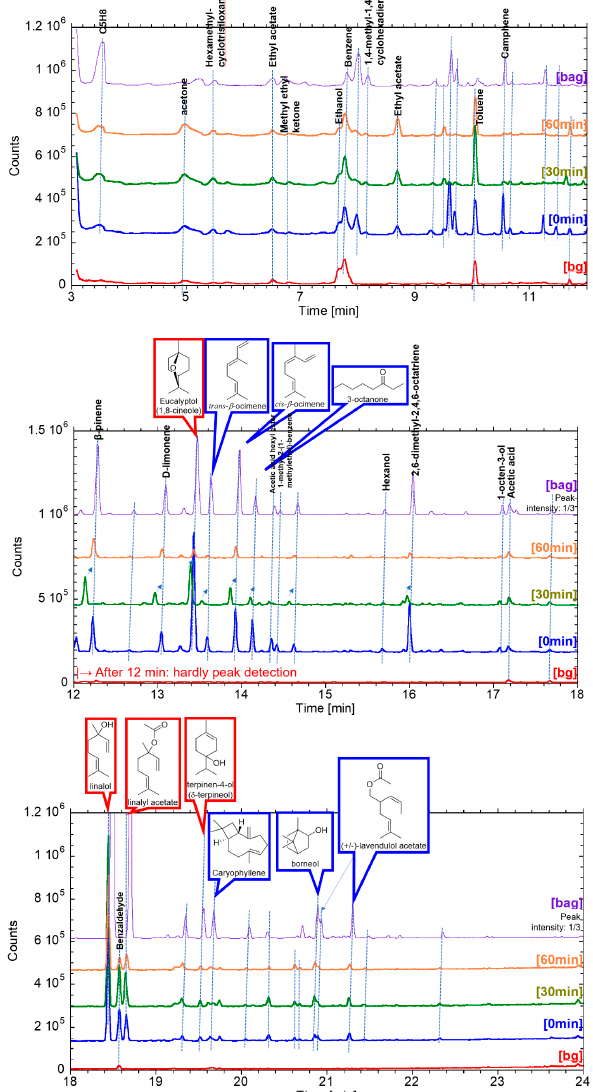
Figure 6. GC/MS chromatogram of lavender. Descriptions of the peaks were from the analysis results using the MS database, and descriptions with structural formulae mean major components of lavender, as listed in Table 1. Samples of [bg] and [bag] chromatogram were the room air before lavender-diffusing as a background measurement and gas from PVDF bag as a reference,